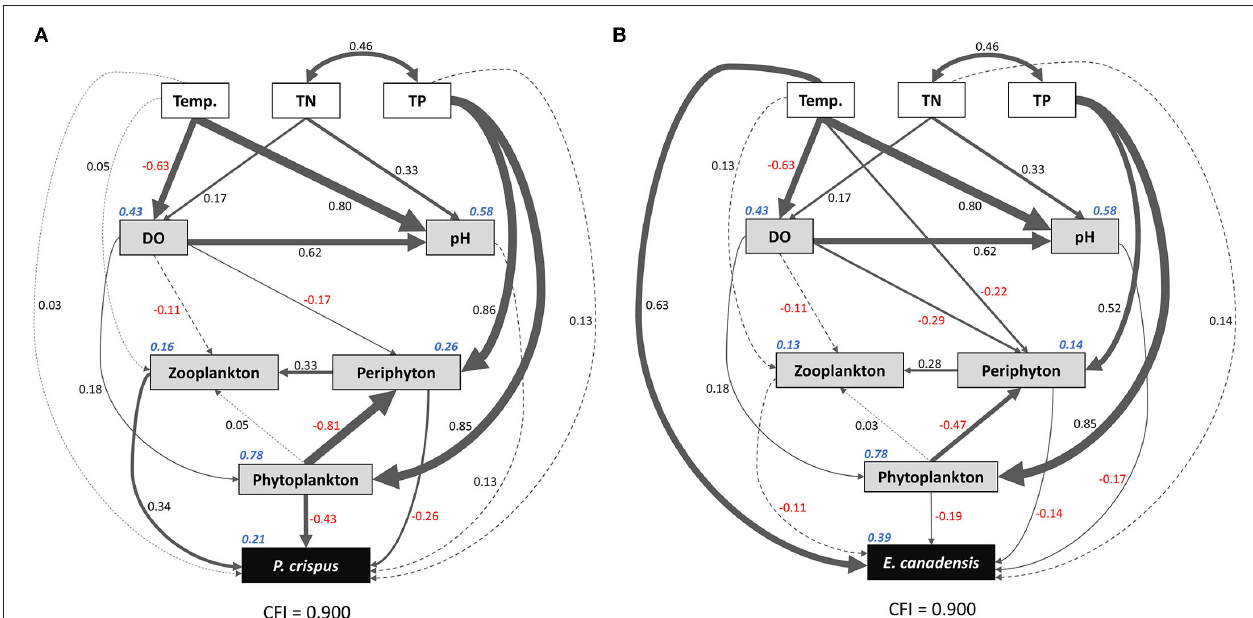
FIGURE 6 | Structural equation model (SEM) showing the direct and indirect pathways by which temperature and nutrients affected the biomass of P. crispus (A) and E. canadensis (B) . Single-headed arrows represent unidirectional causal relationships, and double-headed arrows represent non-causal covariances. Solid lines indicate significant ( p < 0.05) or marginally significant ( p < 0.1) effects, and dashed lines indicate non-significant effects. Numbers adjacent to the lines are standardized path coefficients, analogous to relative regression weights and indicative of the effect sizes of the corresponding relationships. The thickness of the arrows is proportional to the magnitudes of the standardized path coefficients or covariation coefficients. Numbers in italics adjacent to the boxes provide the R 2 values and denote the proportions of submerged macrophyte biomass explained by these parameters. Overall goodness-of-fit tests (CFIs) are shown at the bottom of each figure. Temp., temperature; TN, total nitrogen in water; TP, total phosphorus in water; DO, dissolved oxygen.